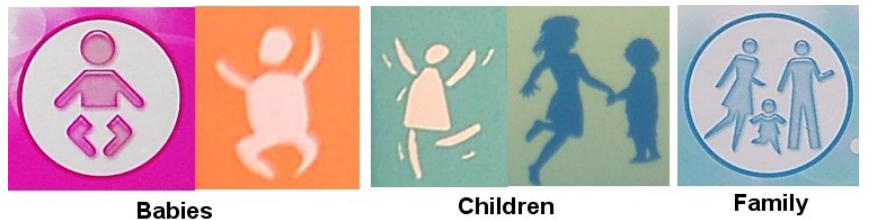
Figure 2. Pictograms showing users.